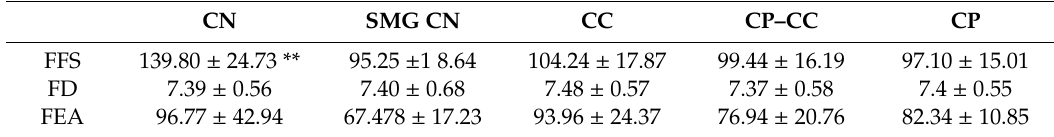
Table 1. Femoral biomechanics analysis.